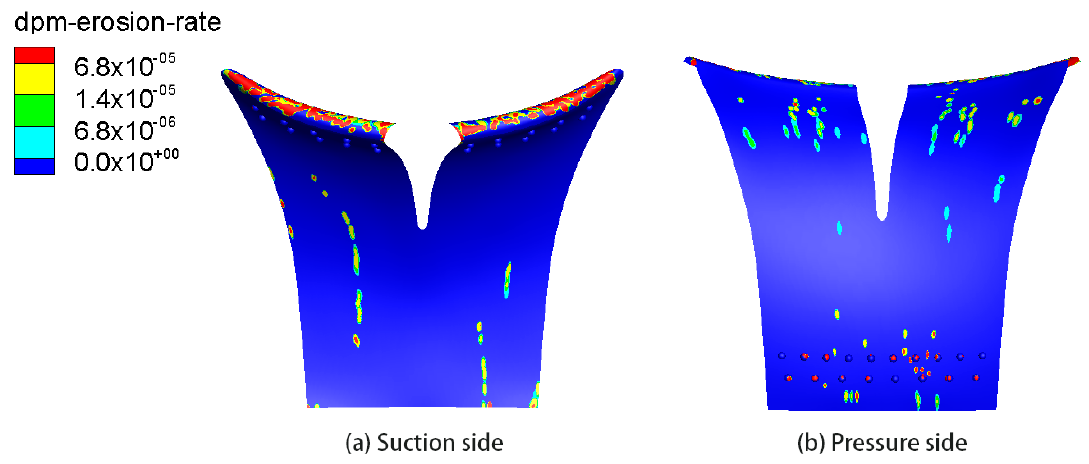
Figure 17. Silt erosion on blade surface with bionic convex domes (units: μ m/s, particle size: 0.12 mm).